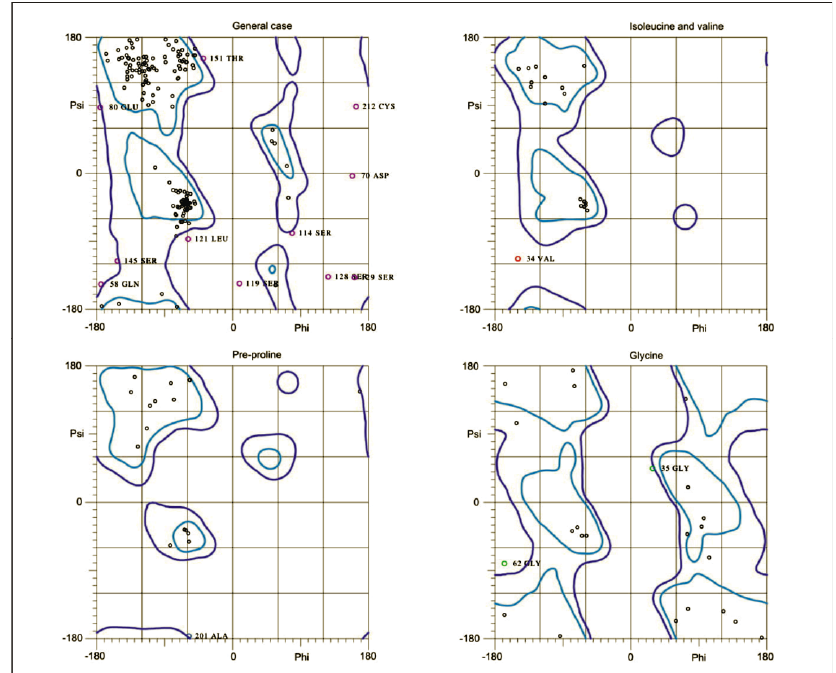
Figure 2. Ramachandran plot of V protein: 3-dimensional model showing 93% residues in most favored, 1% in allowed region, and 6% residues in outlier region.